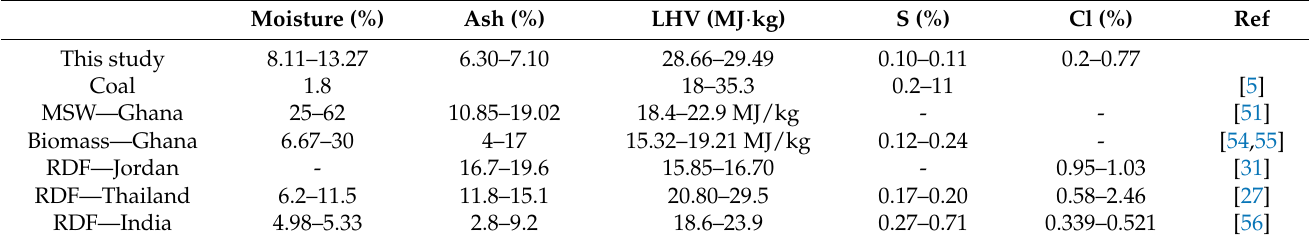
Table 2. Comparison of fuel from other